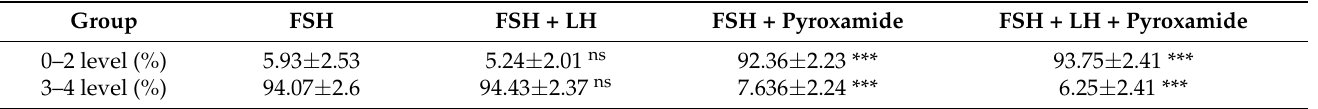
Table 1. Effect of the HDAC1 inhibitor on the cumulus expansion of oocytes ( n = 3). Group